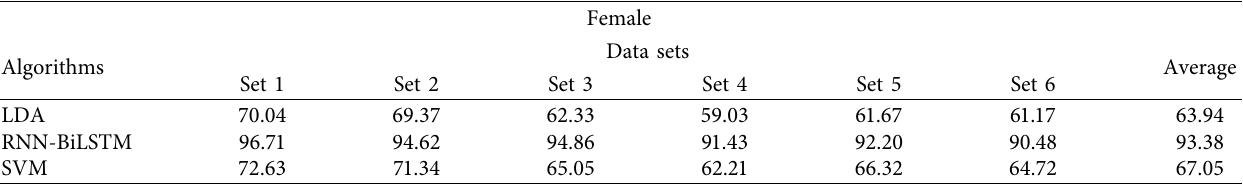
Table 3: Average and recall values for proposed models to identify the female voice samples.